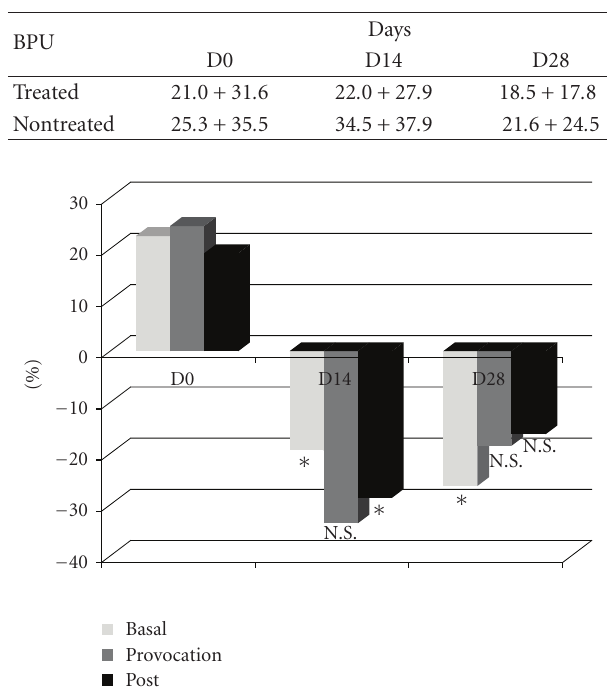
Table 2: Absolute variation means during the dynamical experi- ments.